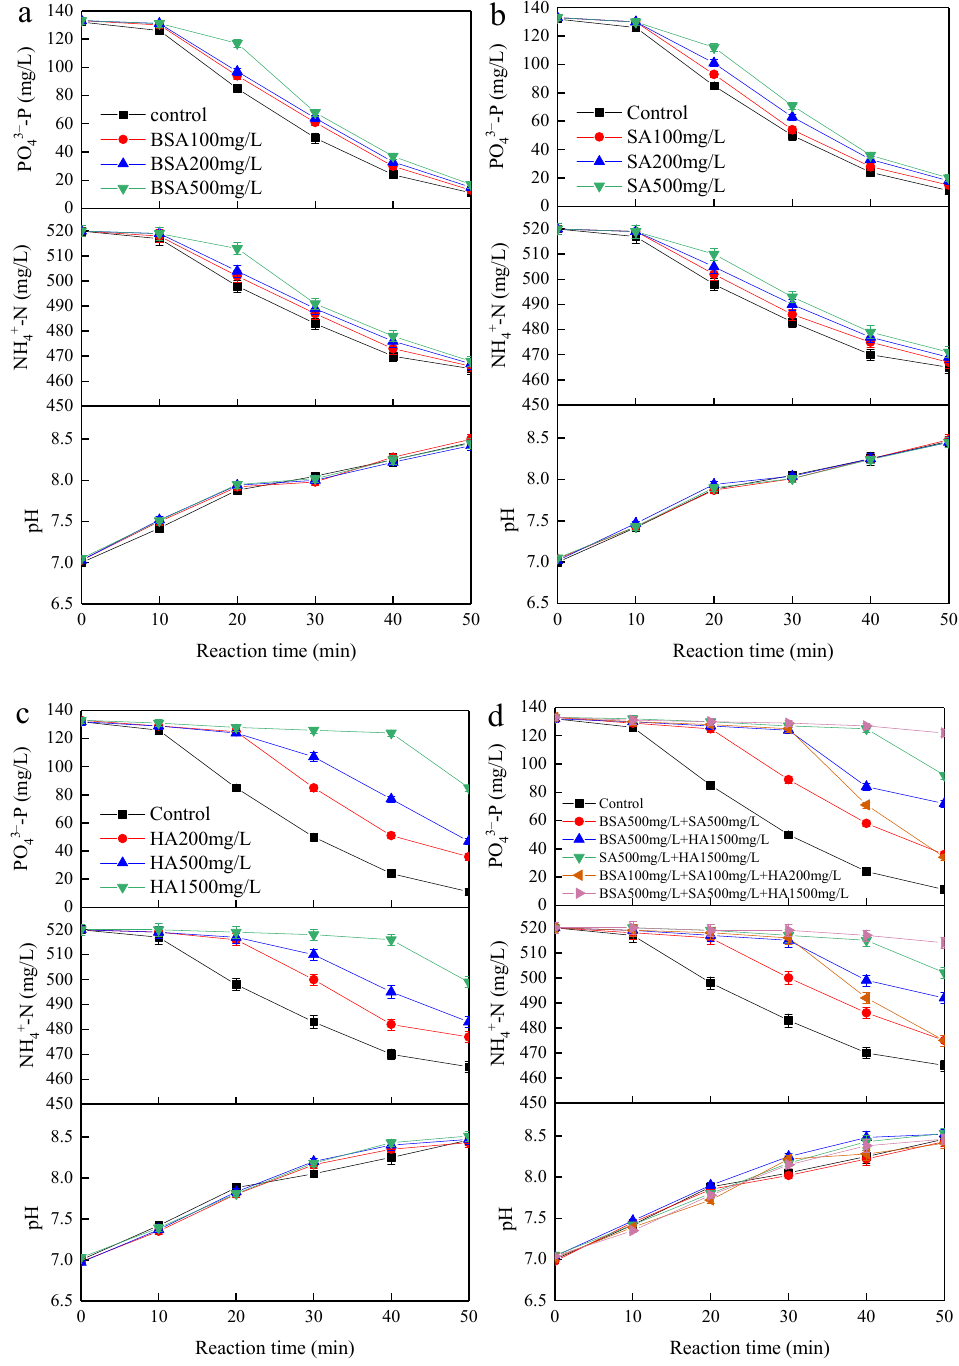
Figure 7. Effect of organic substances under different concentrations: ( a ) for BSA, ( b ) for SA, ( c ) for HA and ( d ) different combinations on nutrients removal.